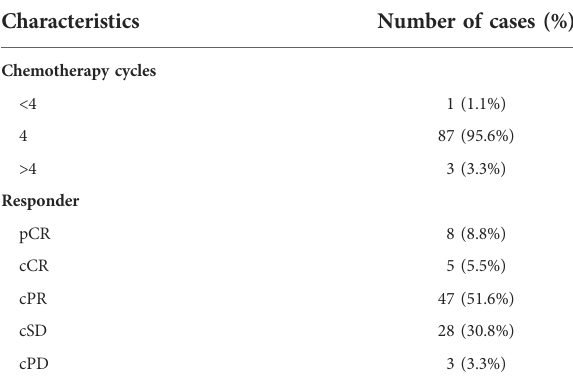
TABLE 5 Baseline clinicopathological characteristics of 91 patients in the follow-up subgroup.